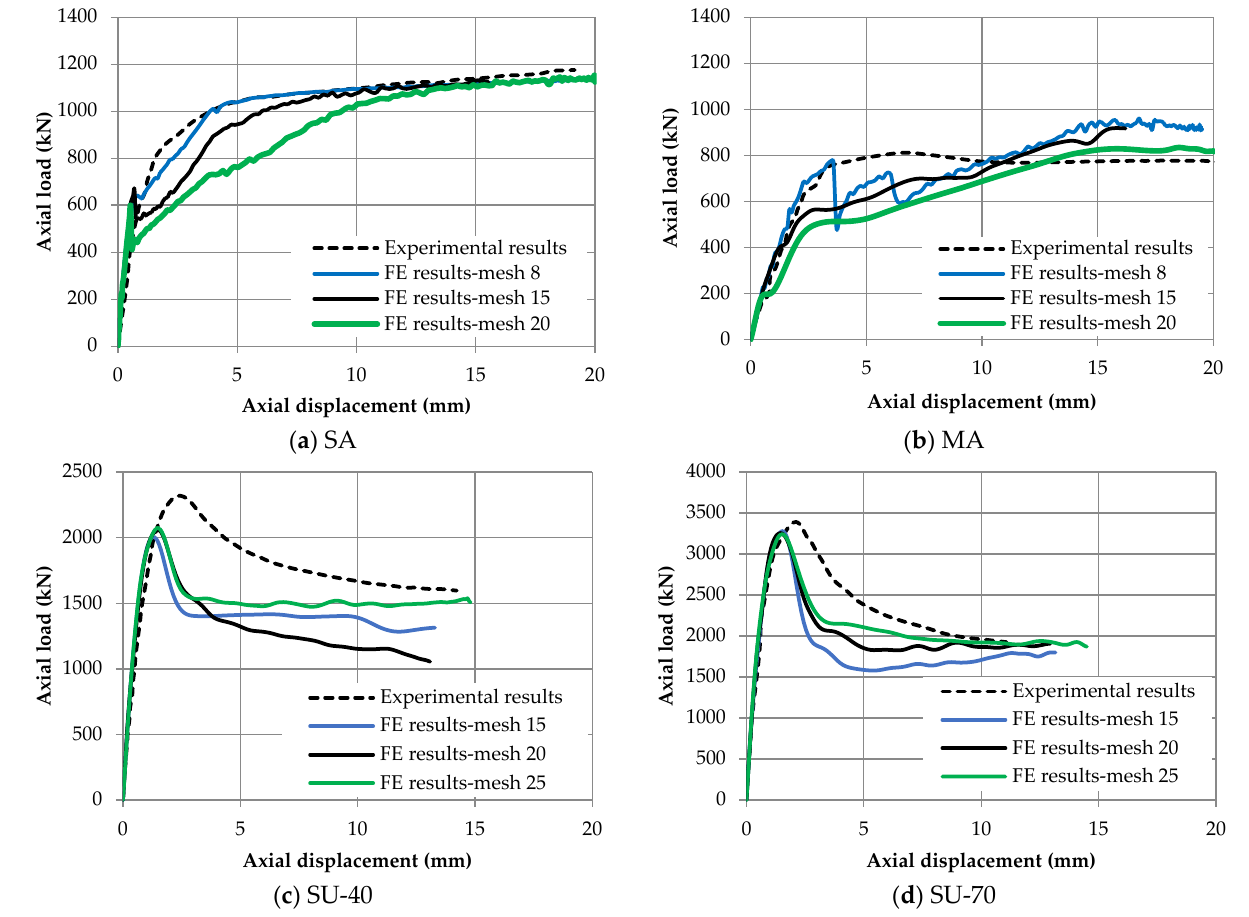
Figure 13. Load-deflection curves of the models simulated at different mesh sizes.